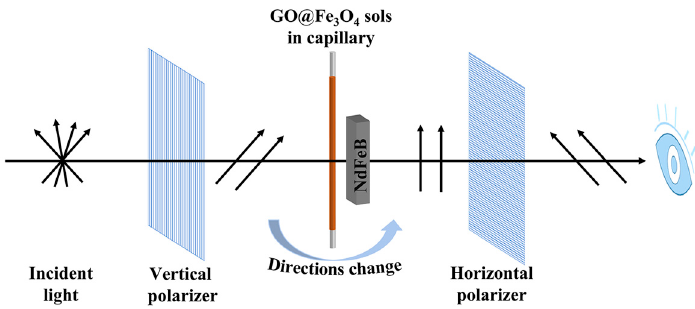
Figure 10. Schematic diagram for the POM characterization.